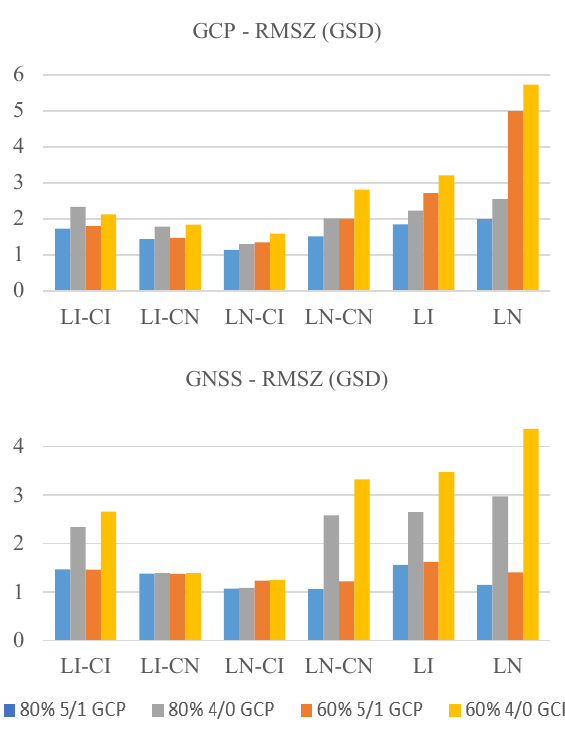
Figure 2 . RMSZ in GSD units for the six basic configurations in the GCP (top) and GNSS (bottom) cases.